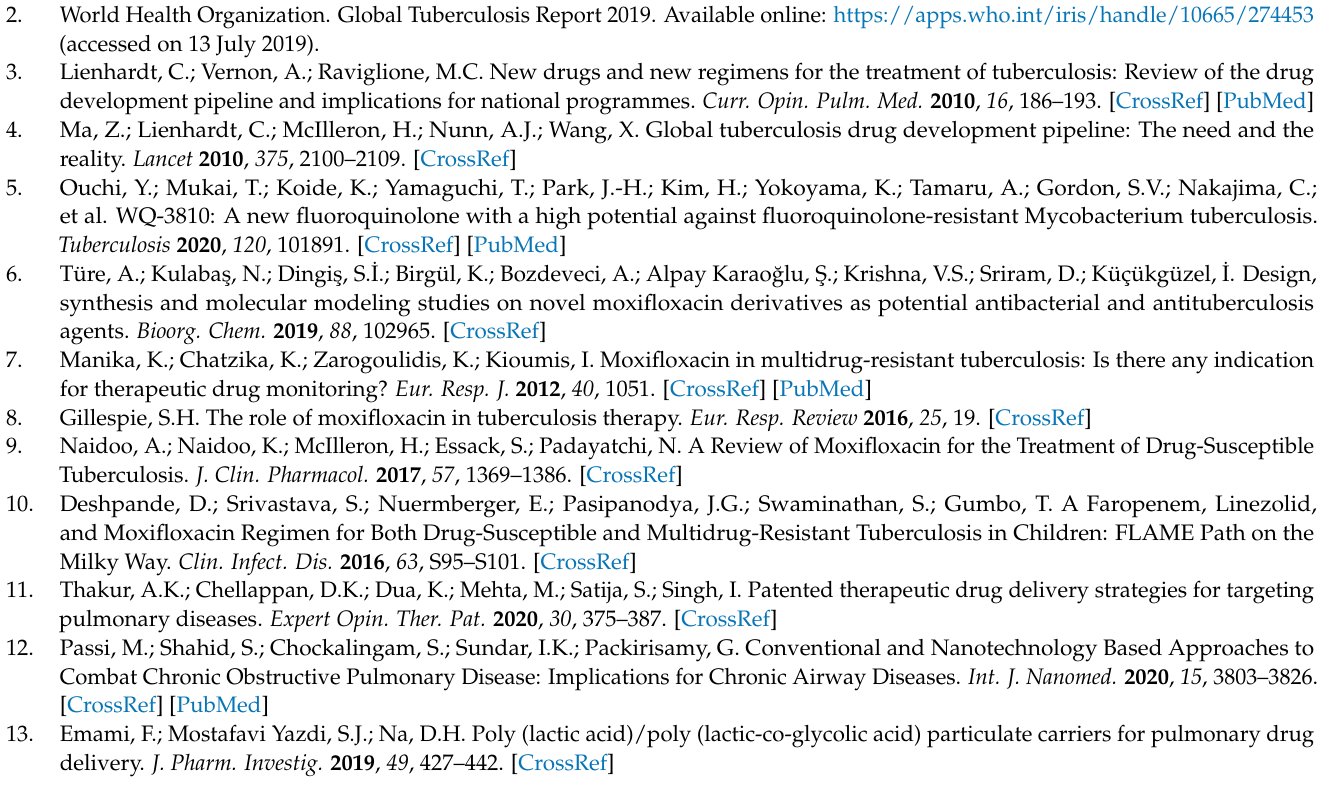
microparticles to mice, Figure S2: Particle size distribution of Optimized MXF-PLGA-MS, Figure S3: Moxifloxacin amount deposited into different stages of Anderson Cascade, Figure S4: Anti- tubercular activity of standard drugs; (P) Pyrazinamide, (C) Ciprofloxacin, (S) Streptomycin, Table S1: Model Parameters for the Studied Response Variables, Table S2: Stability Studies of optimized